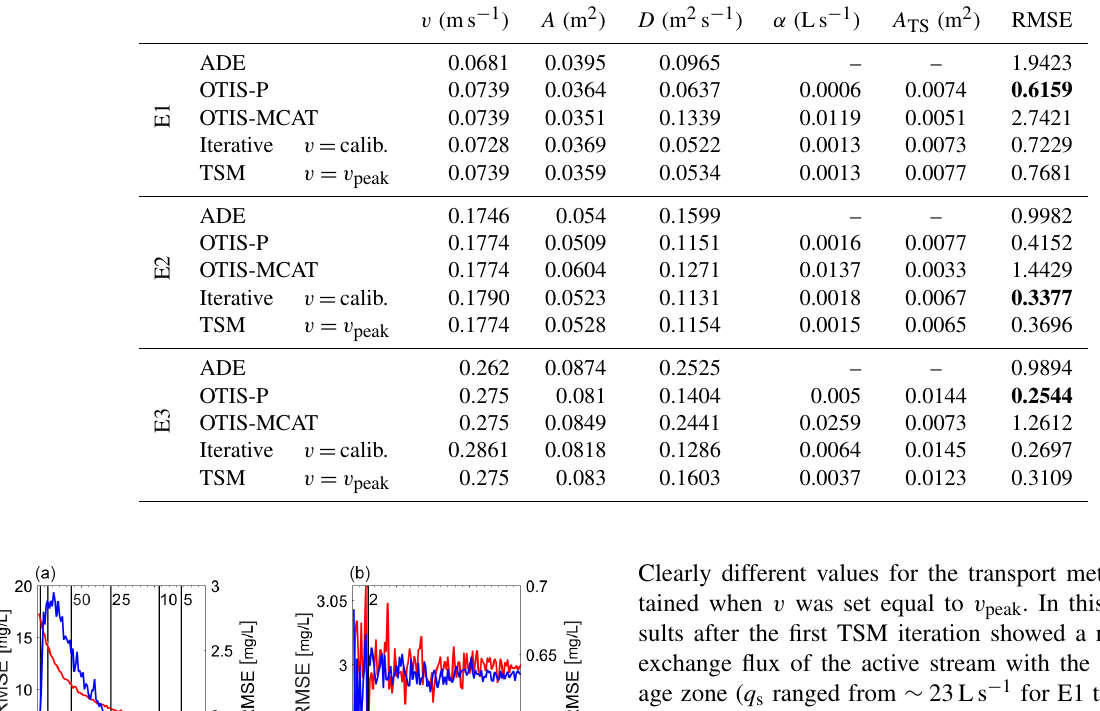
Table 2. Summary of the TSM results. OTIS-MCAT results refer to the case v = v peak without any successive modification of the parameter via dynamic identifiability analysis results. “Iterative TSM” indicates the best parameter sets obtained after the iterative TSM approach presented in Fig. 1 and applied for the cases v considered as a calibrated parameter ( v = calib.) and when it was considered fixed and equal to v peak ( v = v peak ). The best TSM results are indicated in bold font.